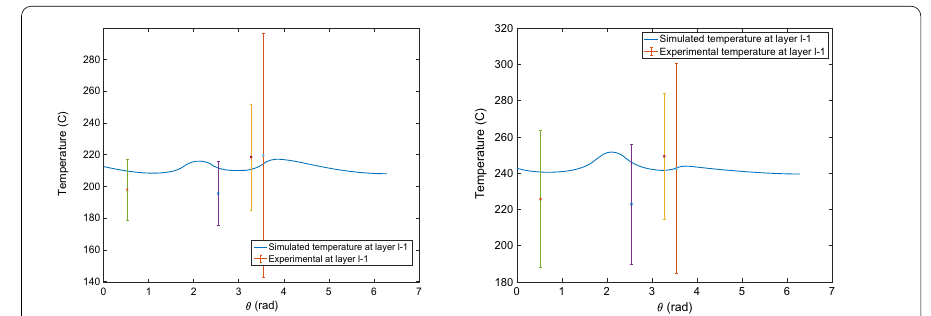
Fig. 7 Comparison of the simulated temperature in the middle of layer l − 1 during the deposition of layer n , with experimental measurements, for l = 3 and l = 5. Temperatures in C